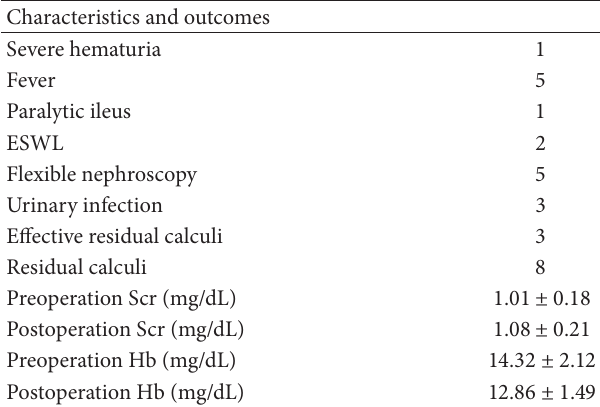
Table 4: Postoperative characteristics and outcomes.